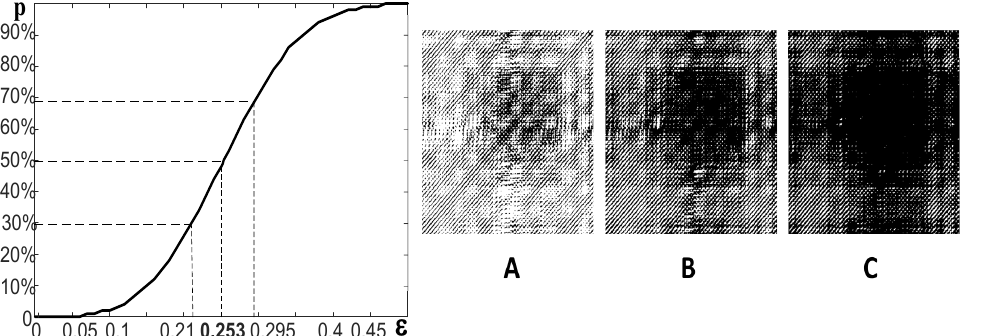
Figure 2. The standard recurrence plot of a normal bearing vibration signal without a fault. The line graph shows the relationship between the percentage of black pixels in the recurrence plot from the threshold parameter ε . The ratio between black and white pixels is equal at ε = 0.253. Part ( A ) shows the standard recurrence plot at ε = 0.21; part ( B ) at ε = 0.144; part ( C ) at ε =